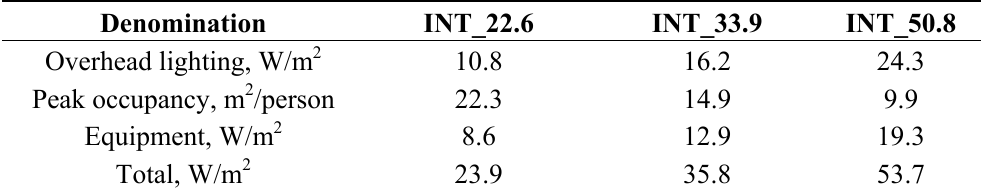
Table 5. Internal load levels investigated for sensitivity